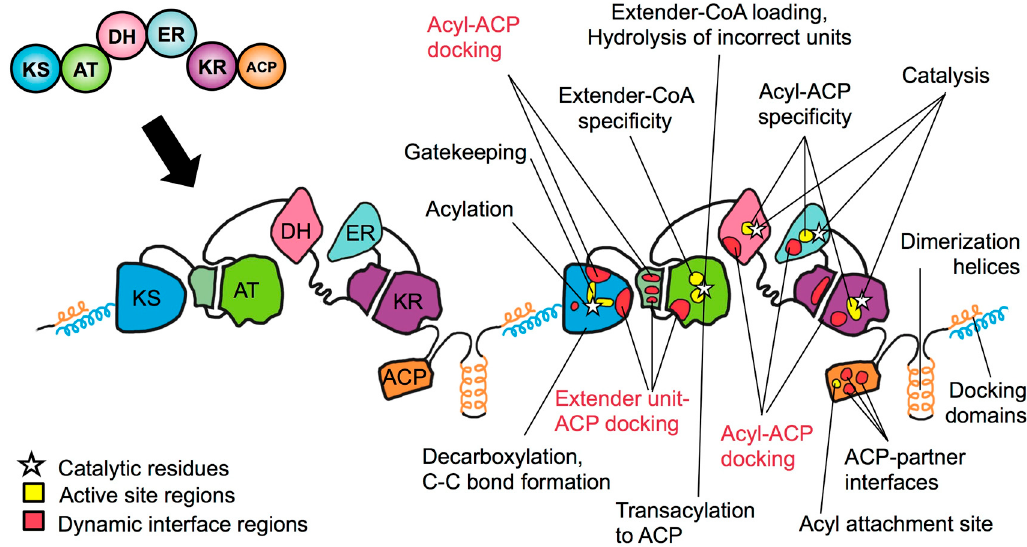
Figure 3. Transition to a more nuanced structure-function map of a polyketide synthase module.